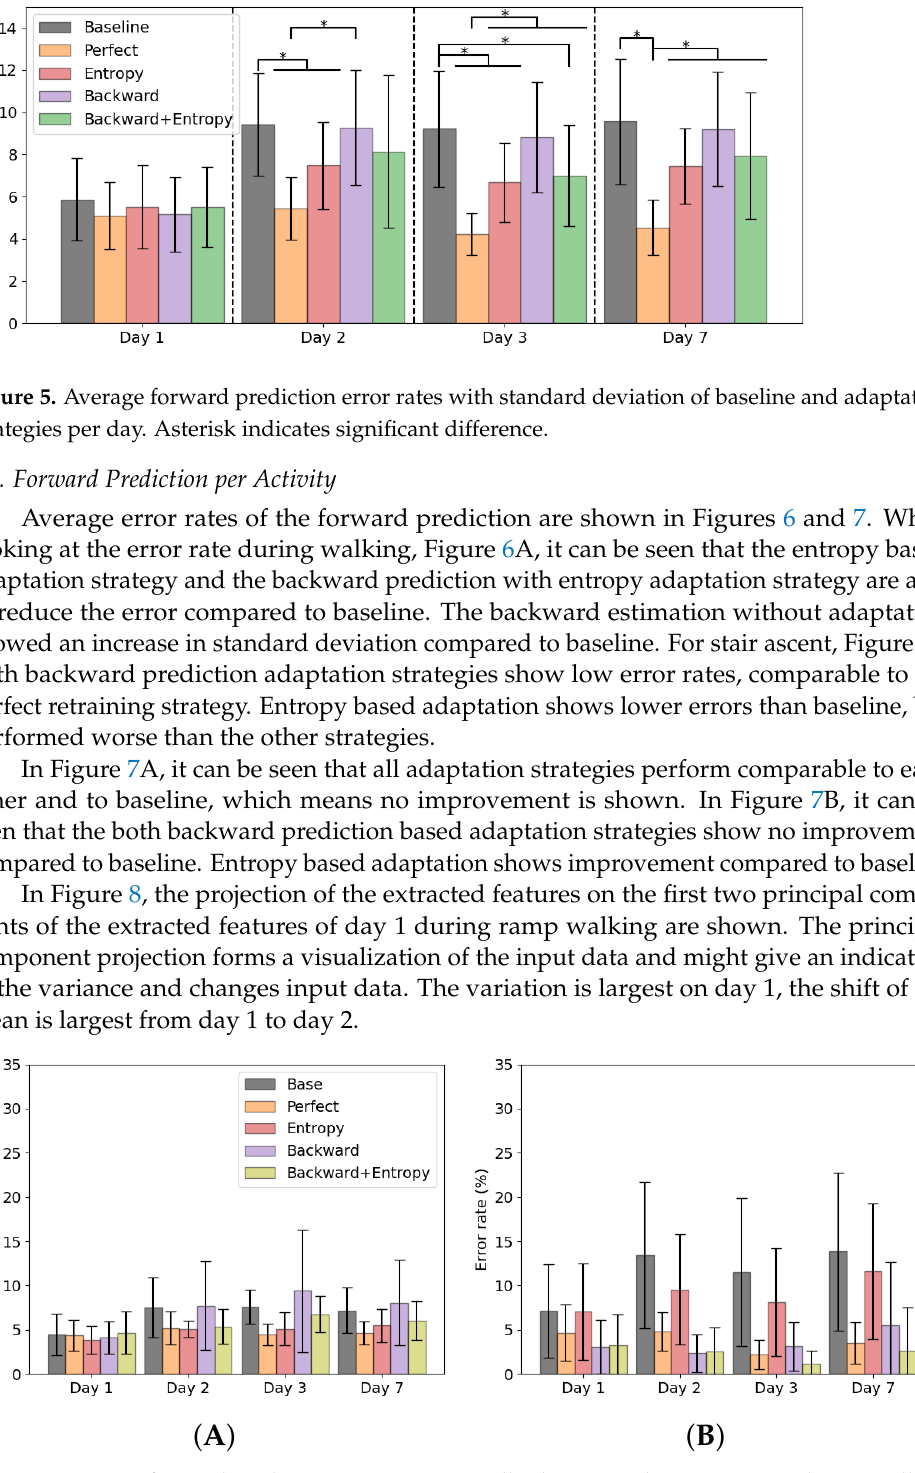
Figure 6. Average forward prediction error rates over all subjects per day per strategy during walking ( A ) and stair ascent ( B